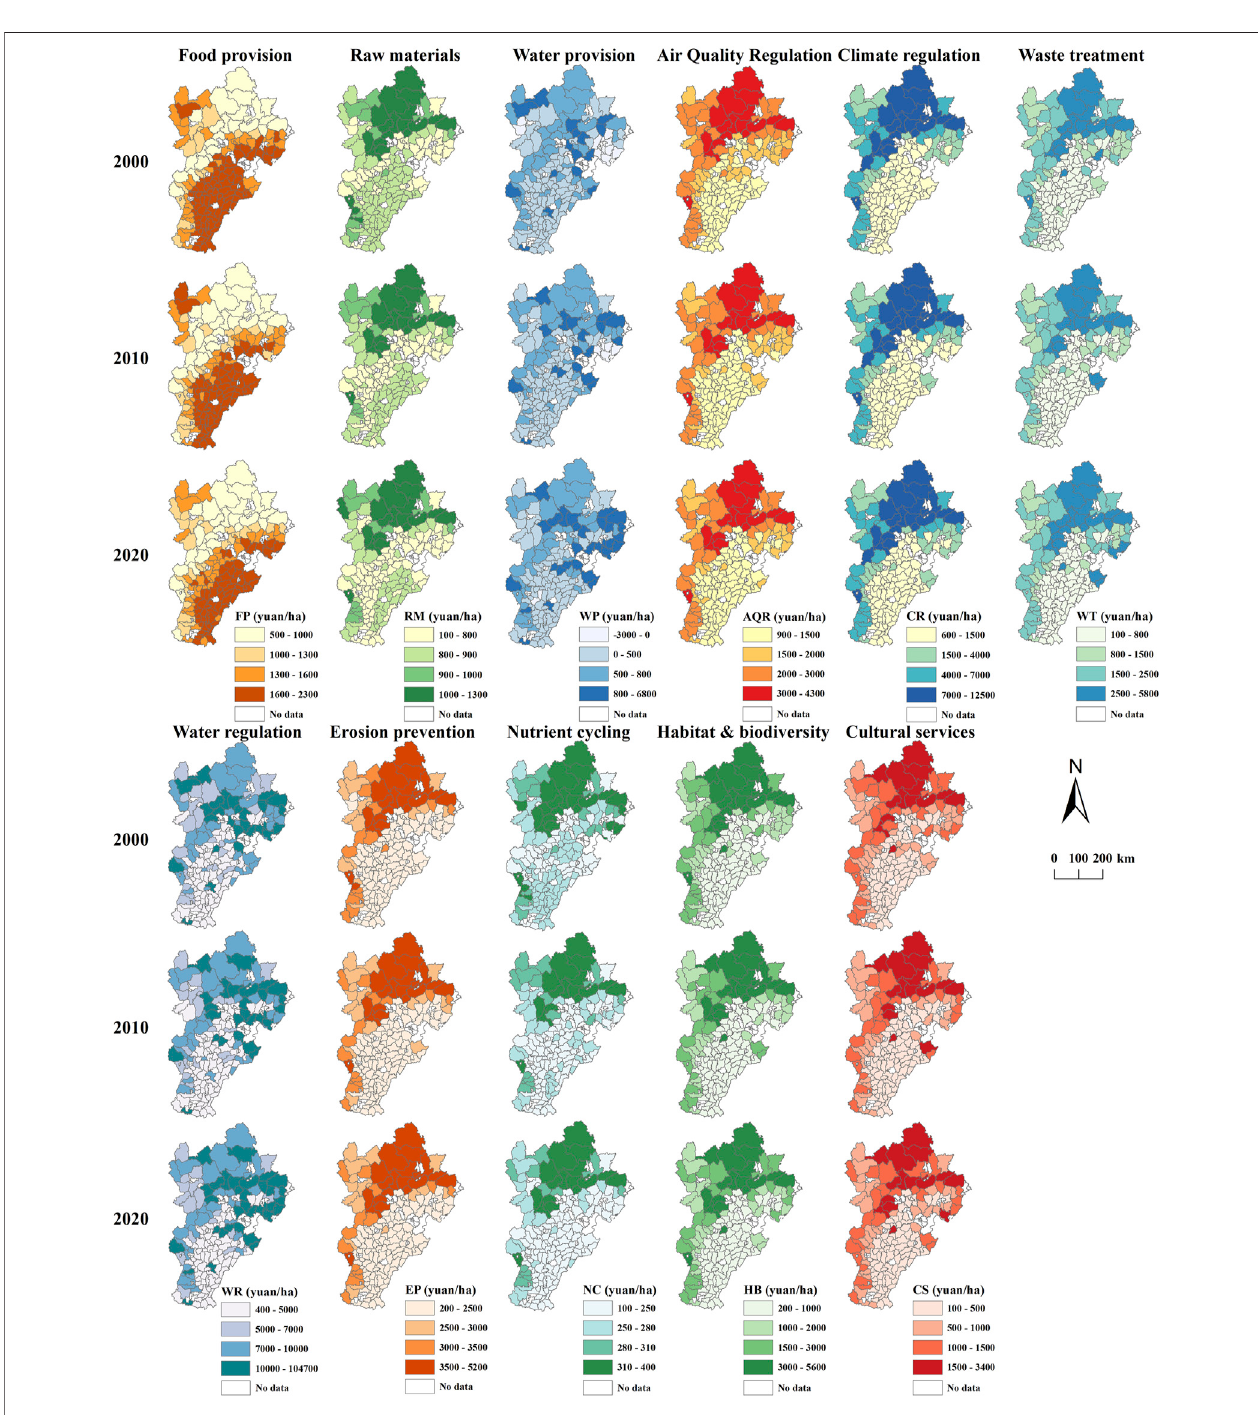
FIGURE 4 | Spatial patterns of the individual ecosystem service values in the Beijing-Tianjin-Hebei region.